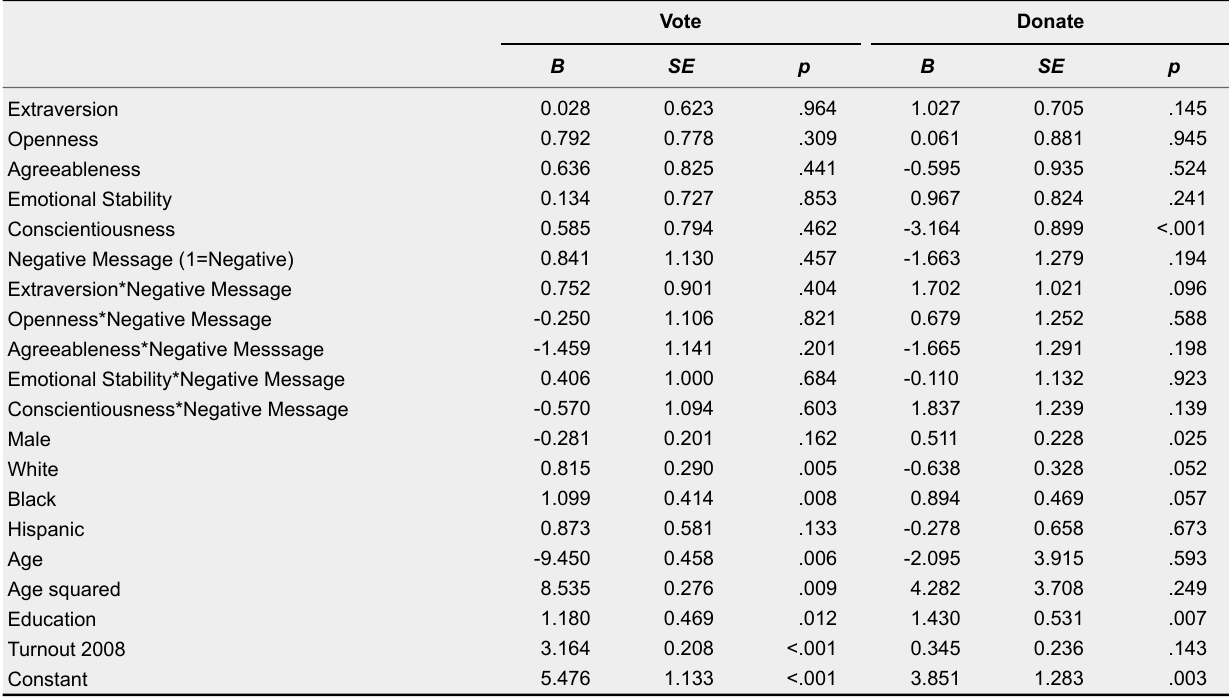
Linear Regression Models (OLS) of Political Participation, Vote and Donate Intentions (N =